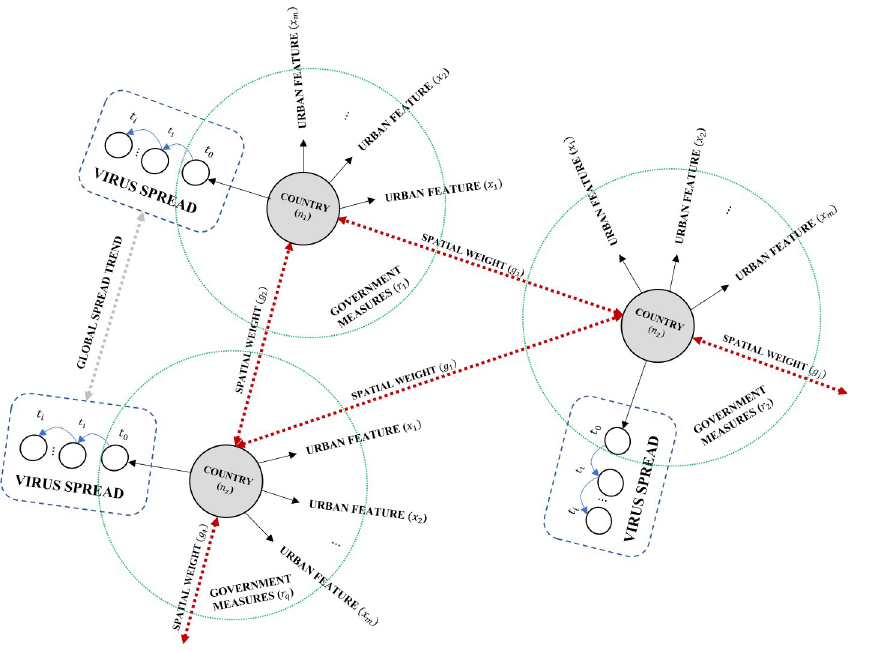
Fig 1. The concept for structuring the graph for the proposed variational-LSTM autoencoder.